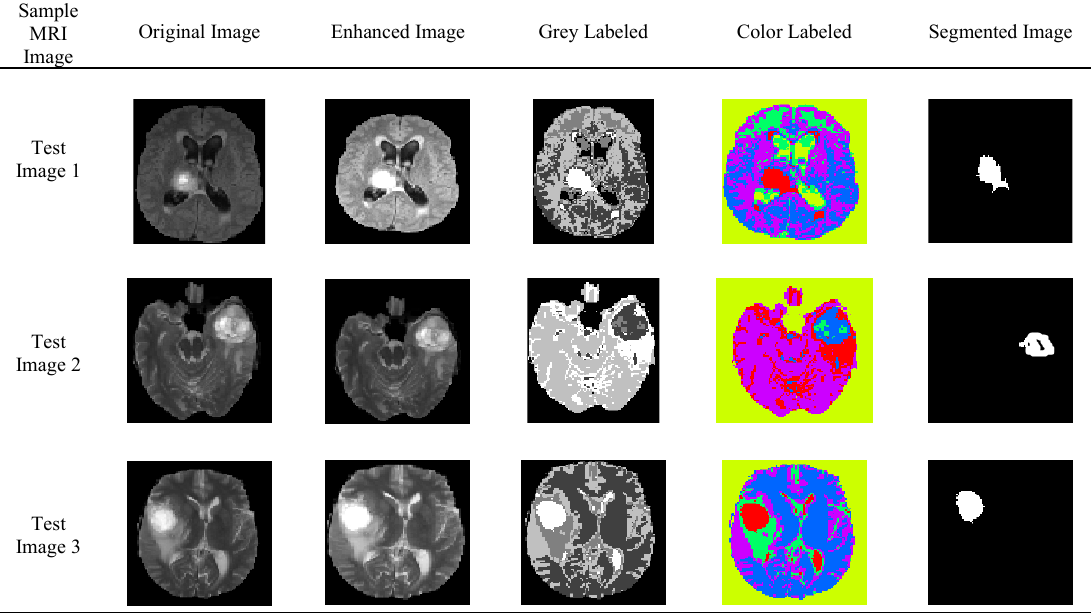
Table 3. Image Segmentation using k-means with Firefly Algorithm